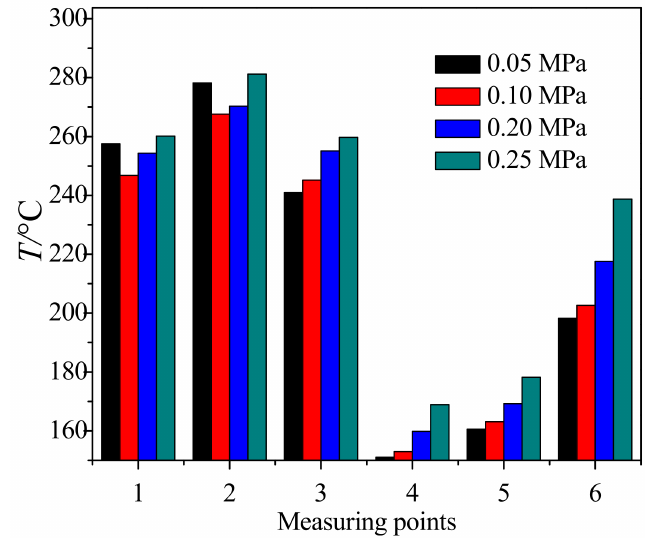
Figure 8. Effect of cooling system pressure on the temperature. Table 5. Fuzzy evaluation table for performance evaluation of the water-cooling system of the turbocharger bearing